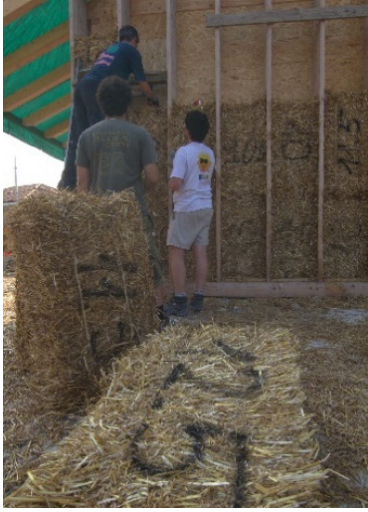
Figure 3. Dimensions and placement of straw bales: on their edges (sides), face up; flat, visible sides.